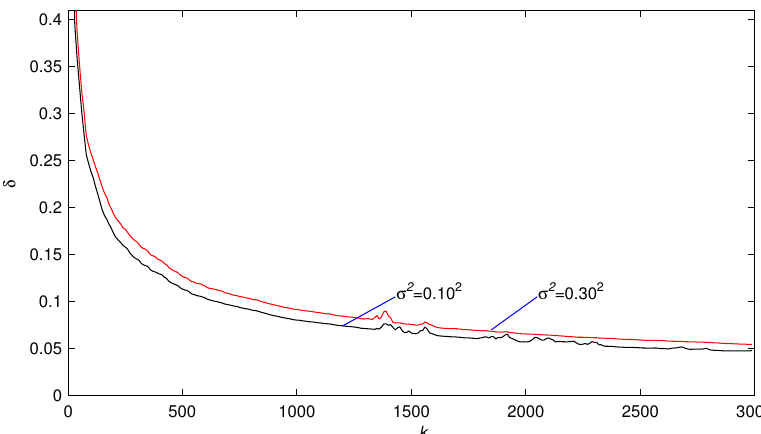
Figure 7. The F-M-ML-MIESG estimation errors versus k with different σ 2 ( p =